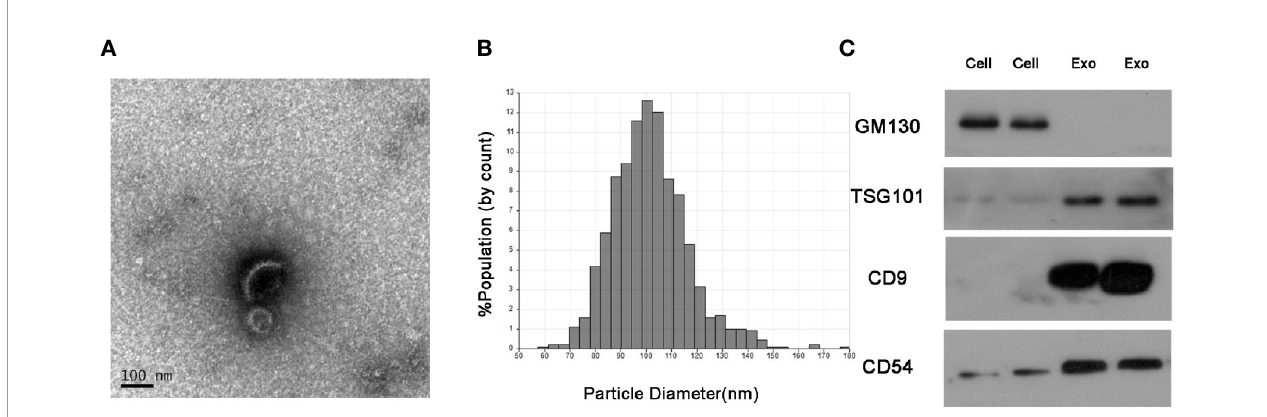
FIGURE 1 | Identi fi cation of isolated serum exosomes. (A) Representative TEM images of exosomes isolated from the sera of NSCLC patients. (B) Size distribution of exosomes ranging from 50 – 150 nm as analyzed by qNano system. (C) Immunoblots showing expression levels of the exosomal proteins CD9, CD54 and